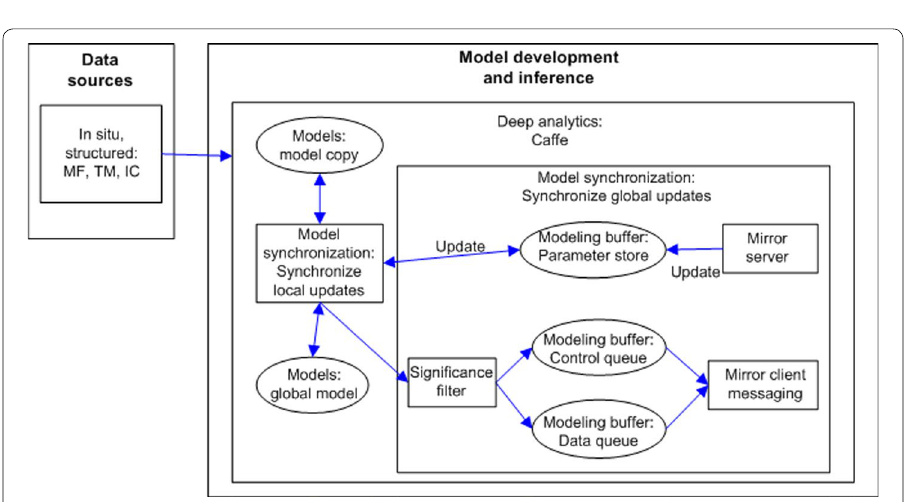
Fig. 18 The mapping of Gaia [37] to the big data